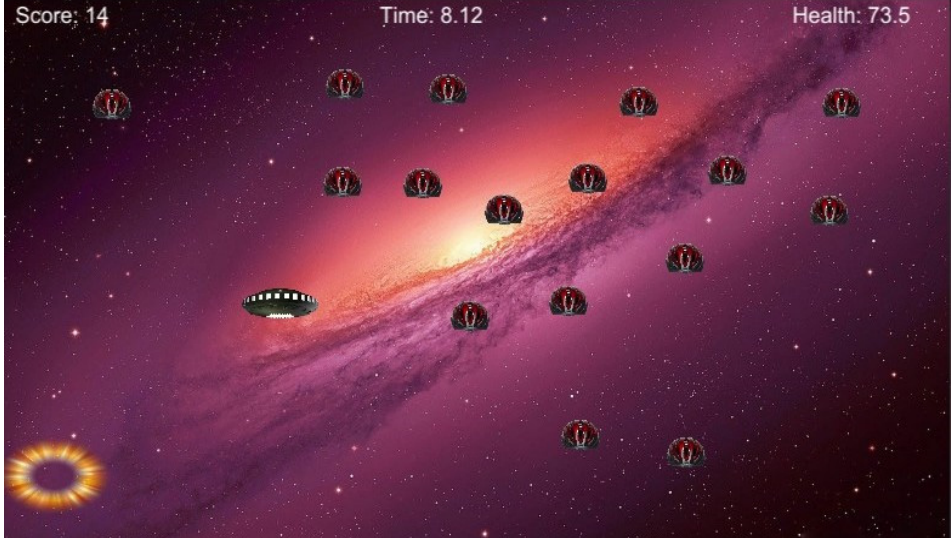
Figure 3. Simulated game-like scenario, where we have time and energy constraints. Agents (or human) must return to its power base, at the lower-left corner of the screen, in order to restore its health (level of energy).